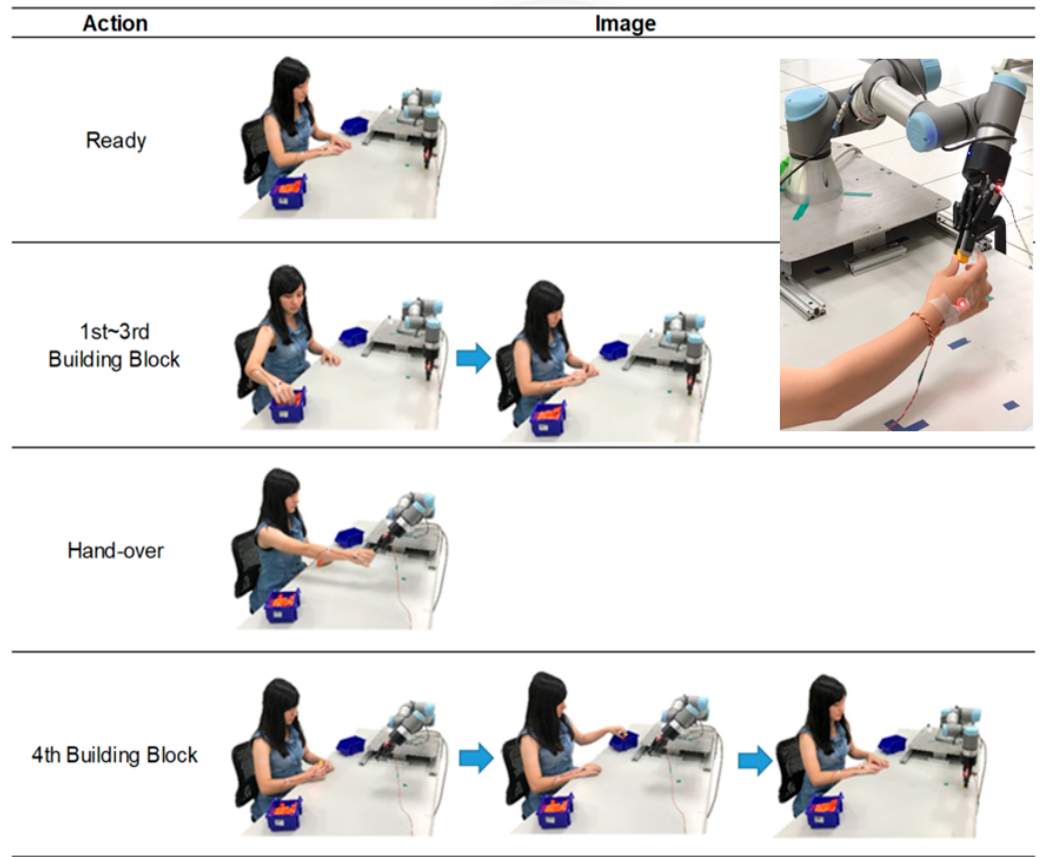
Figure 2. Experimental workflow diagram with an inset figure showing a close-up actual human–robot physical interaction.